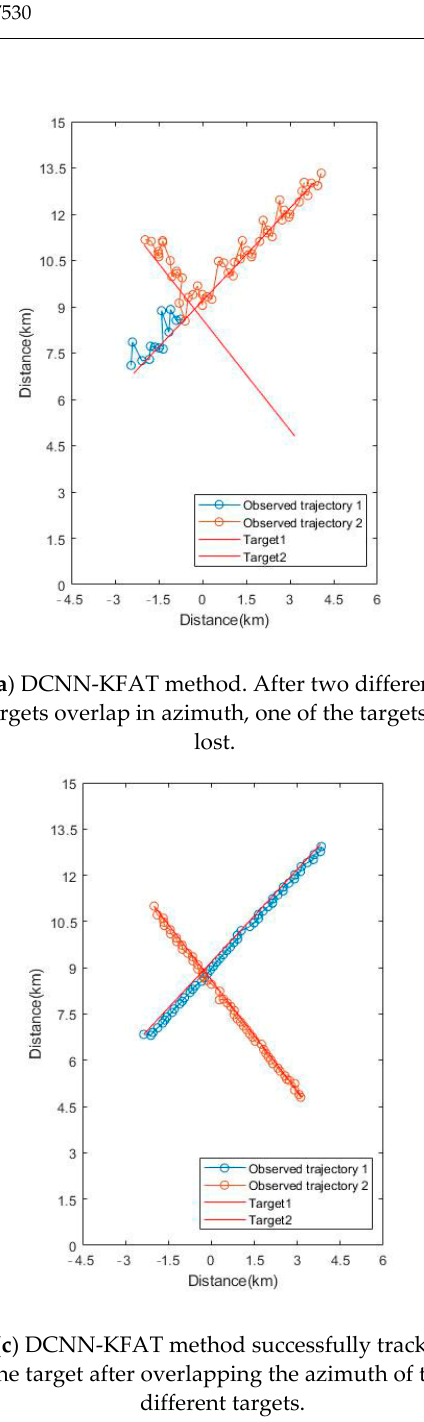
Figure 16. Tracking two azimuth crossing targets.